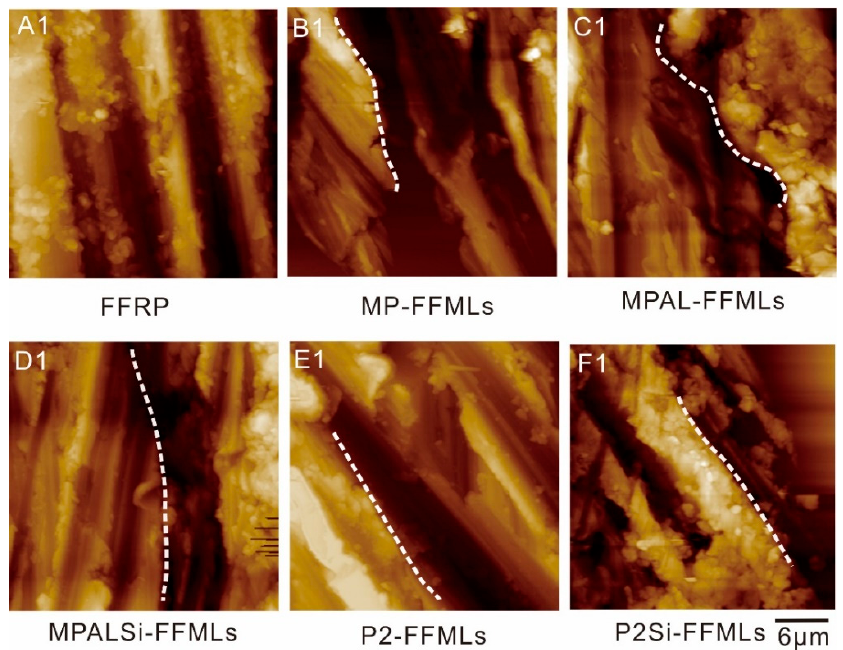
Figure 7. AFM height images of the flax fiber-reinforced plastic (FFRP) and the five type of modified flax fiber–metal laminates (FFMLs).